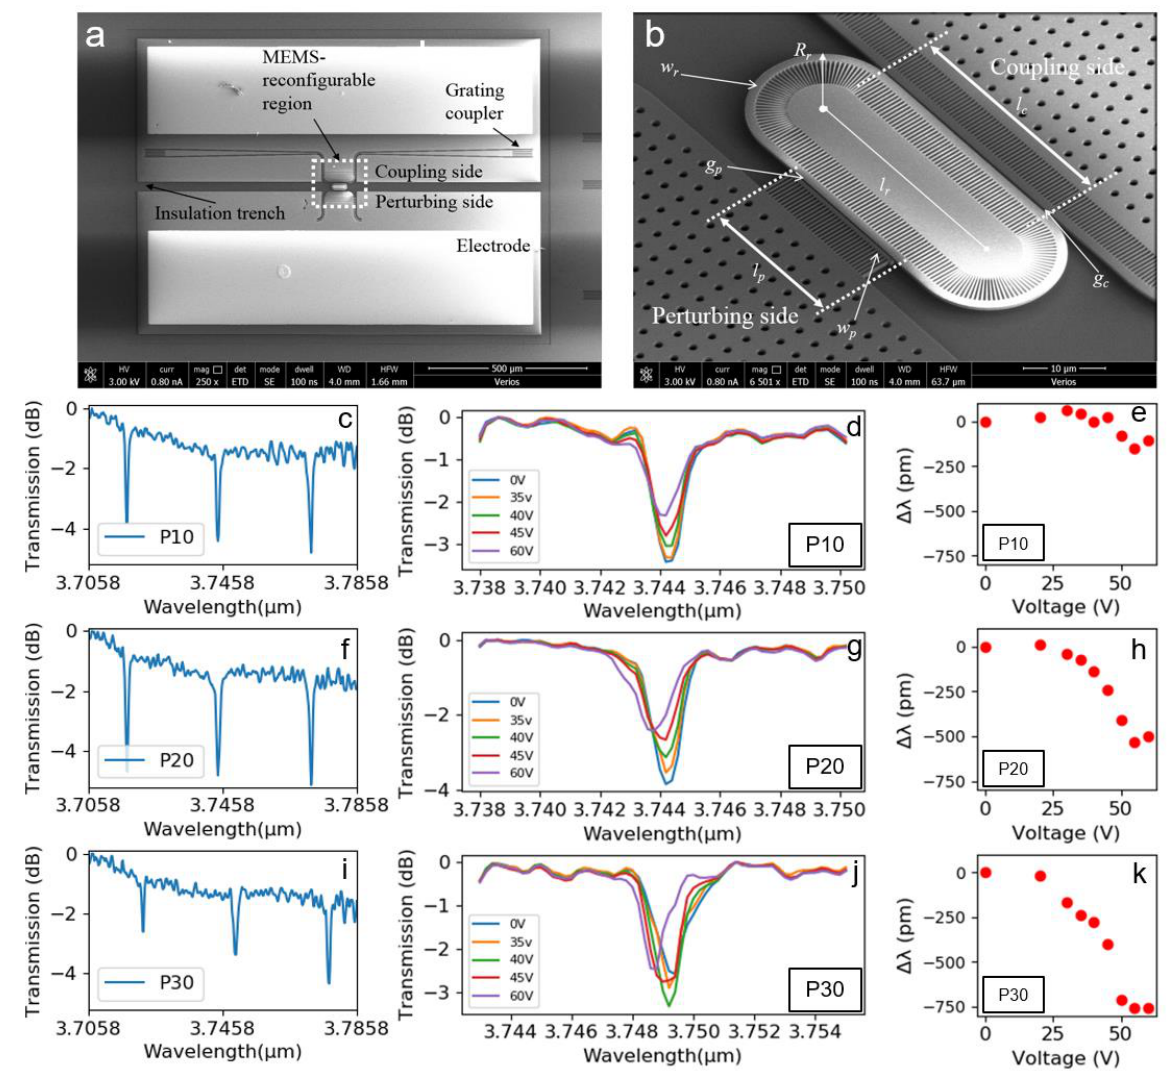
Figure 7. ( a , b ) SEM photos of the experimental devices. ( c – e ) Measured results of P10. ( f – h ) Measured results of P20. ( i – k ) Measured results of P30.